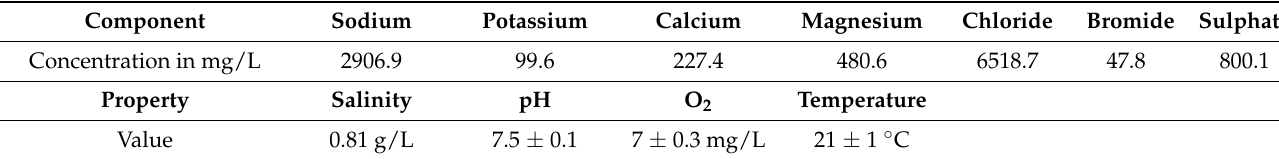
Table 3. Seawater composition and properties.